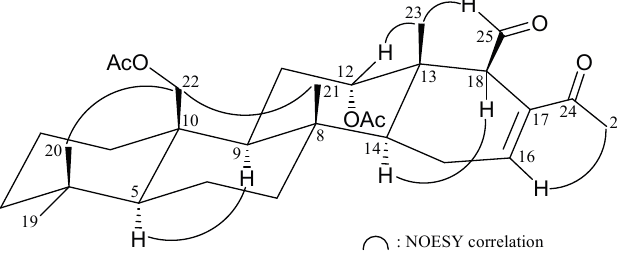
Figure 3. Selective NOESY correlations of 2 .